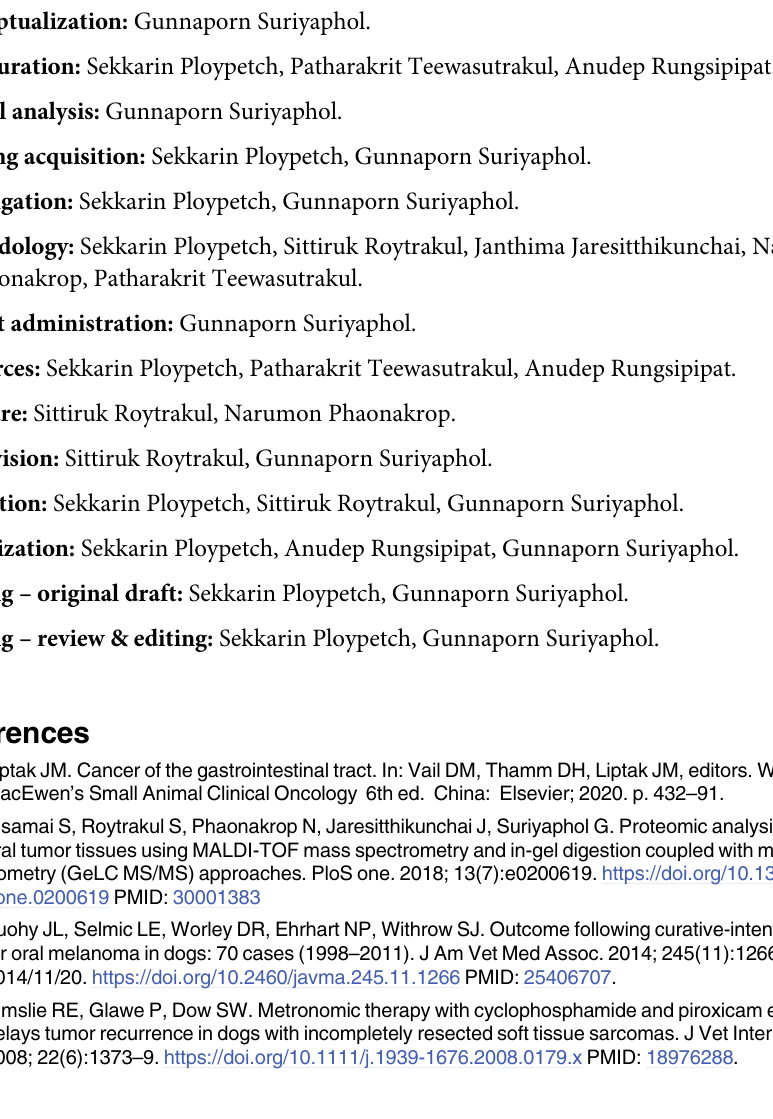
S2 Table. Common proteins found in all individuals with OM during post-surgery stage. S3 Table. Common proteins found in all individuals with OM during